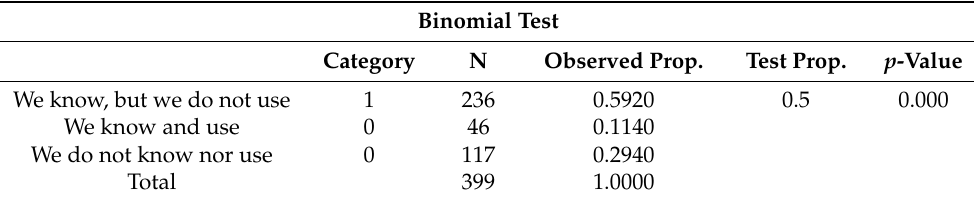
Table 3. Binomial test results for hypothesis